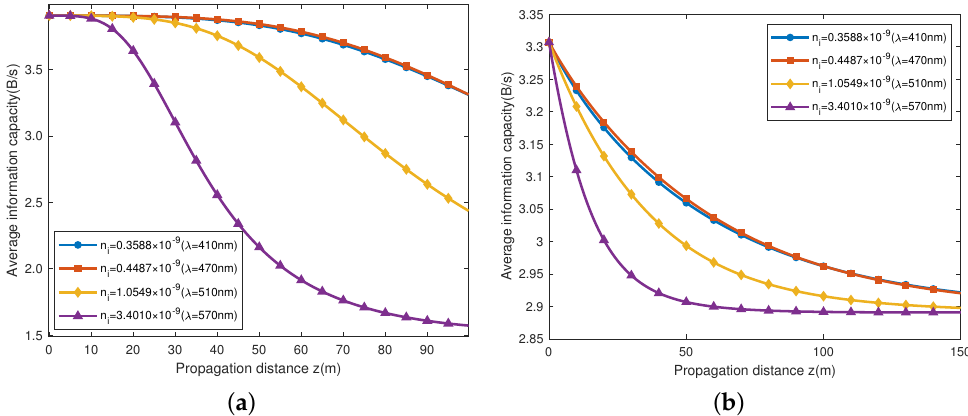
Figure 9. The capacity of the POV carrier link versus propagation distance for wavelength and image refractive index under ( a ) 4-QAM, z = 100 m, ( b ) 256-QAM, z = 150